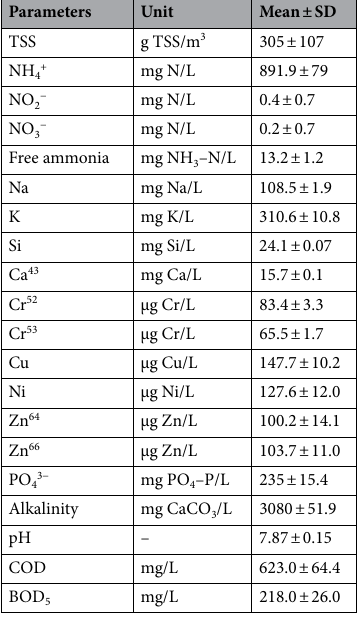
Table 1. Composition of the pre-Ostara biosolid digestate